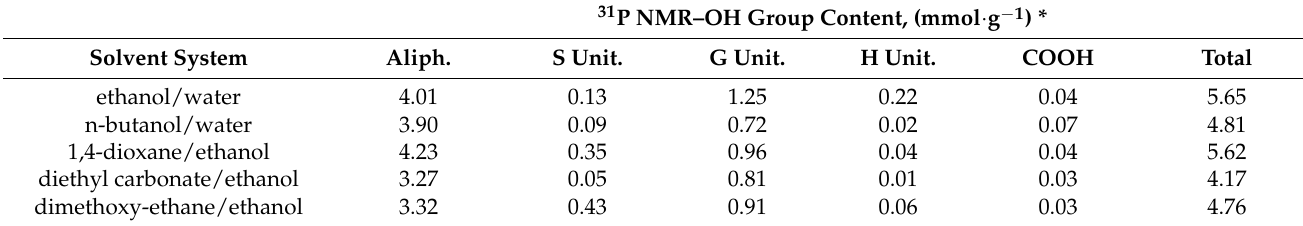
Table 6. Hydroxyl group content in precipitated lignin enriched fractions.